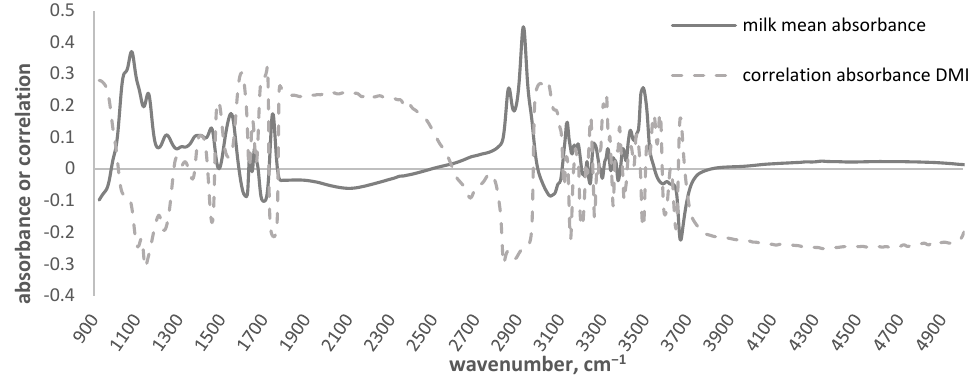
Figure 4. Plot of the overlapping values of the correlation between the dry matter intake (DMI) and the milk absorbance at given wavenumber, and that of the average MIR spectra of milk samples. The regions showing the highest correlations between the DMI and milk absorbance were between ~1100 and 1300 cm −1 and between ~2800 – 3000 cm −1 . However, as reported